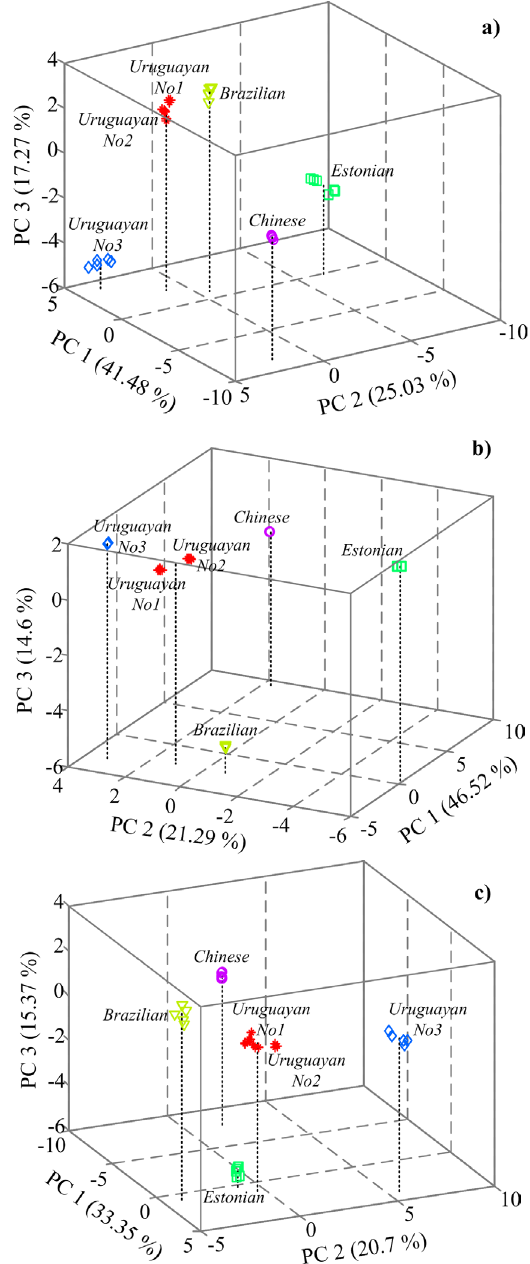
Figure 3. Data scatter plots of K-Means cluster analysis, projected in the principal components space, using different data pre-processing techniques (a – no data pre-processing, b – inverse data pre-processing, c – logarithmic data pre-